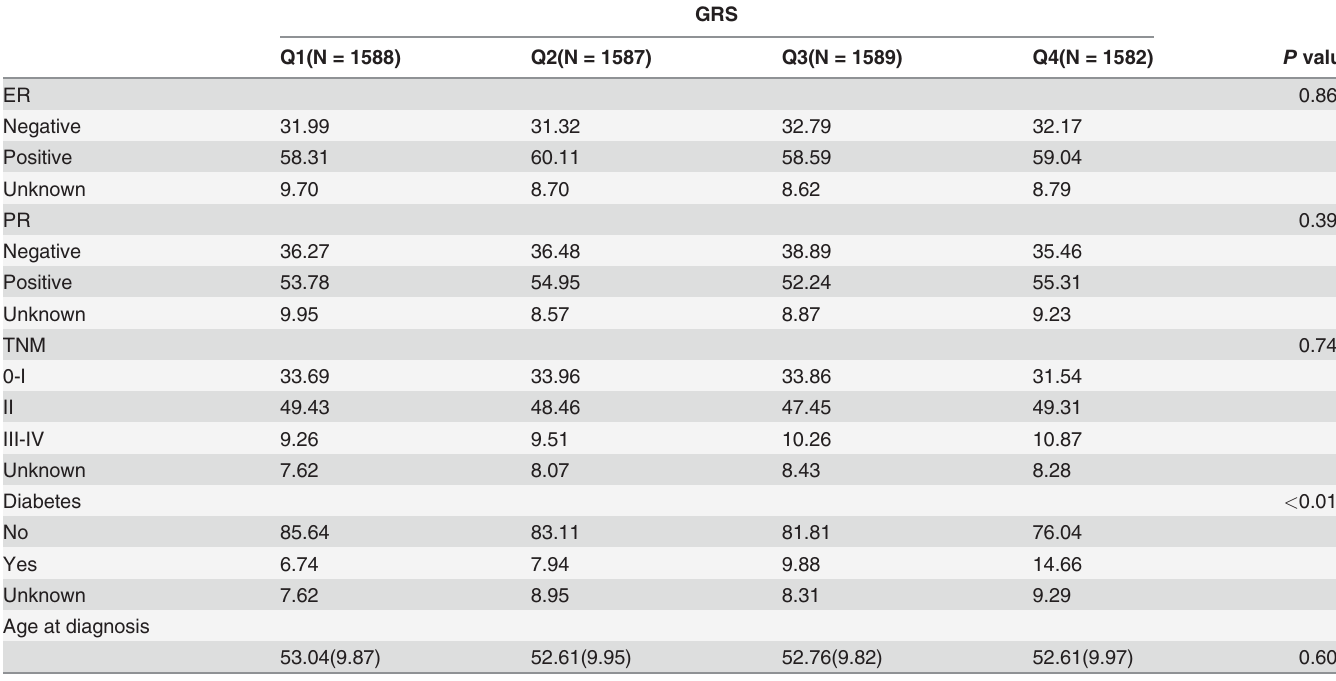
Table 2. Associations of diabetes Genetic Risk Score (GRS) with clinical